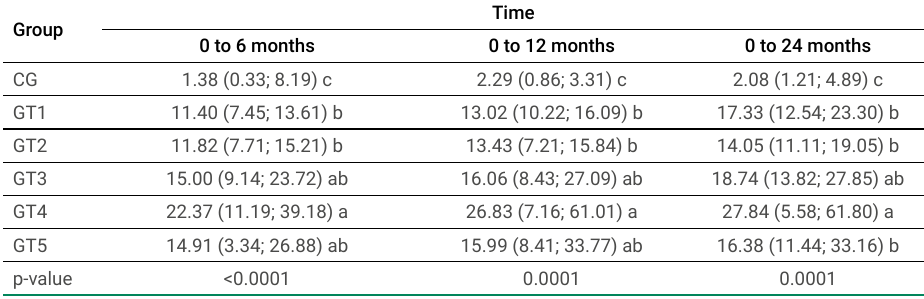
Table 5. Median (minimum; maximum) of